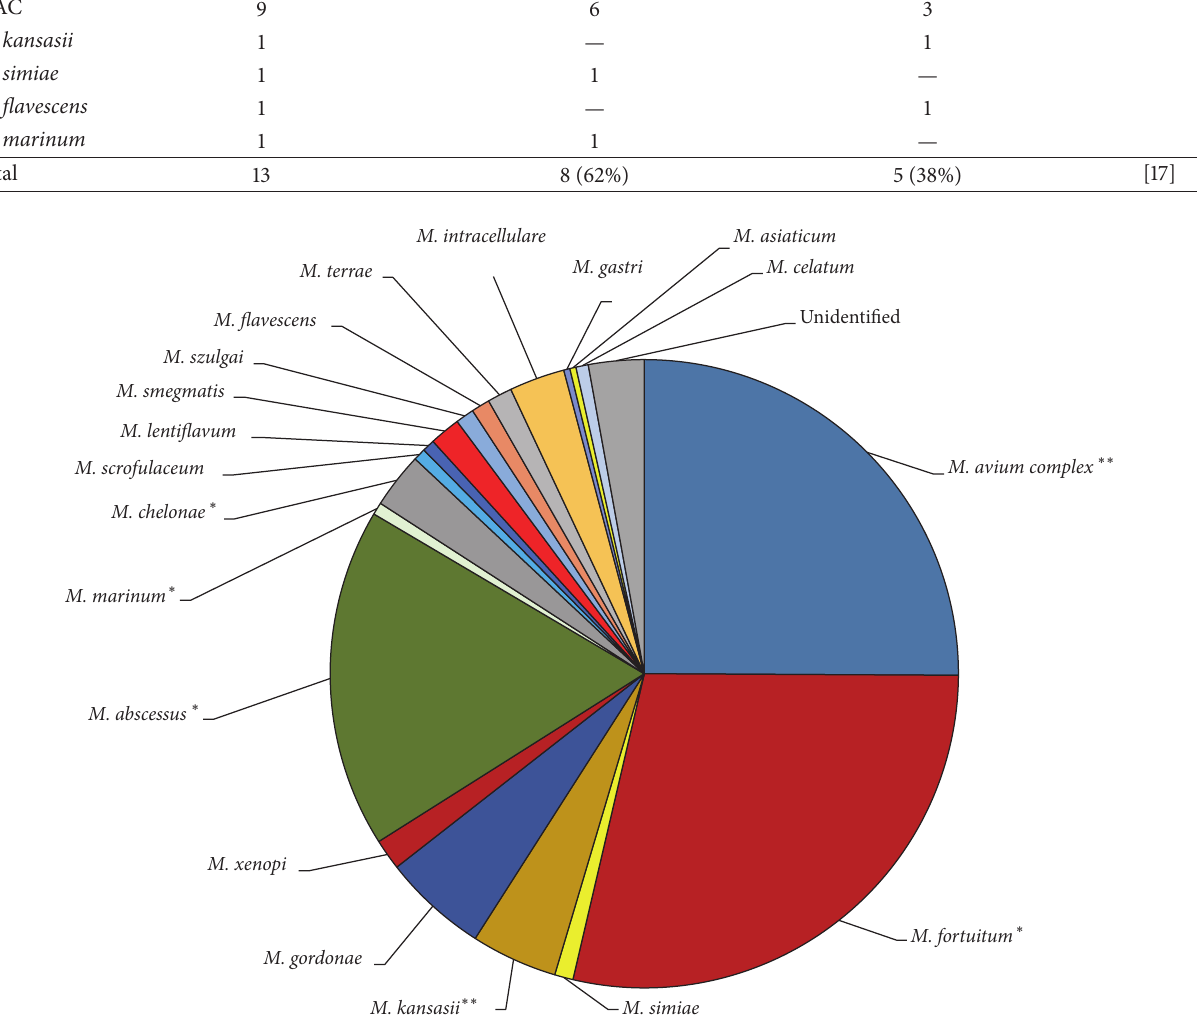
Figure 1: Clinical diversity of NTM in the Gulf countries. Illustrating the clinical diversity of NTM in three different GCC countries: Saudi Arabia, Kuwait, and Oman. The ∗∗ sign is designated for species reported from Saudi Arabia, Kuwait, and Oman. The ∗ sign, however, indicates that a species is reported from two GCC countries (Saudi Arabia and Oman or Saudi Arabia and Kuwait). Species shown in this figure with (no sign) are only reported from one GCC country. References